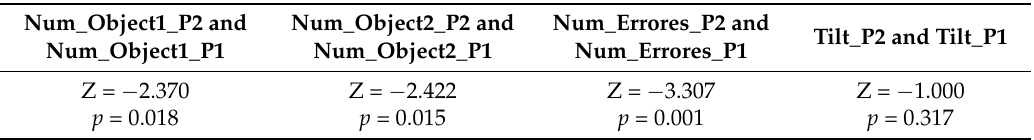
Table 3. Wilcoxon signed ranks test statistic.